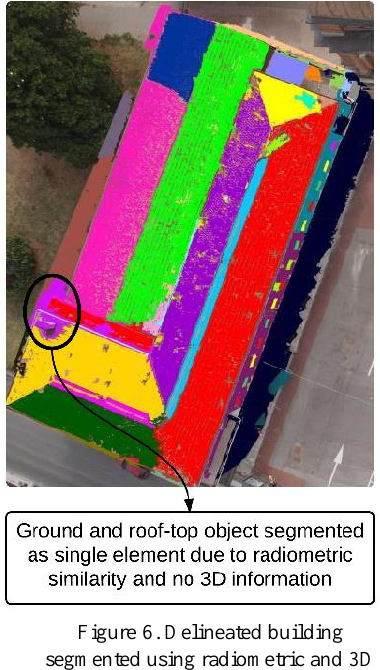
Figure 6. Delineated building segmented using radiometric and 3D geometric features